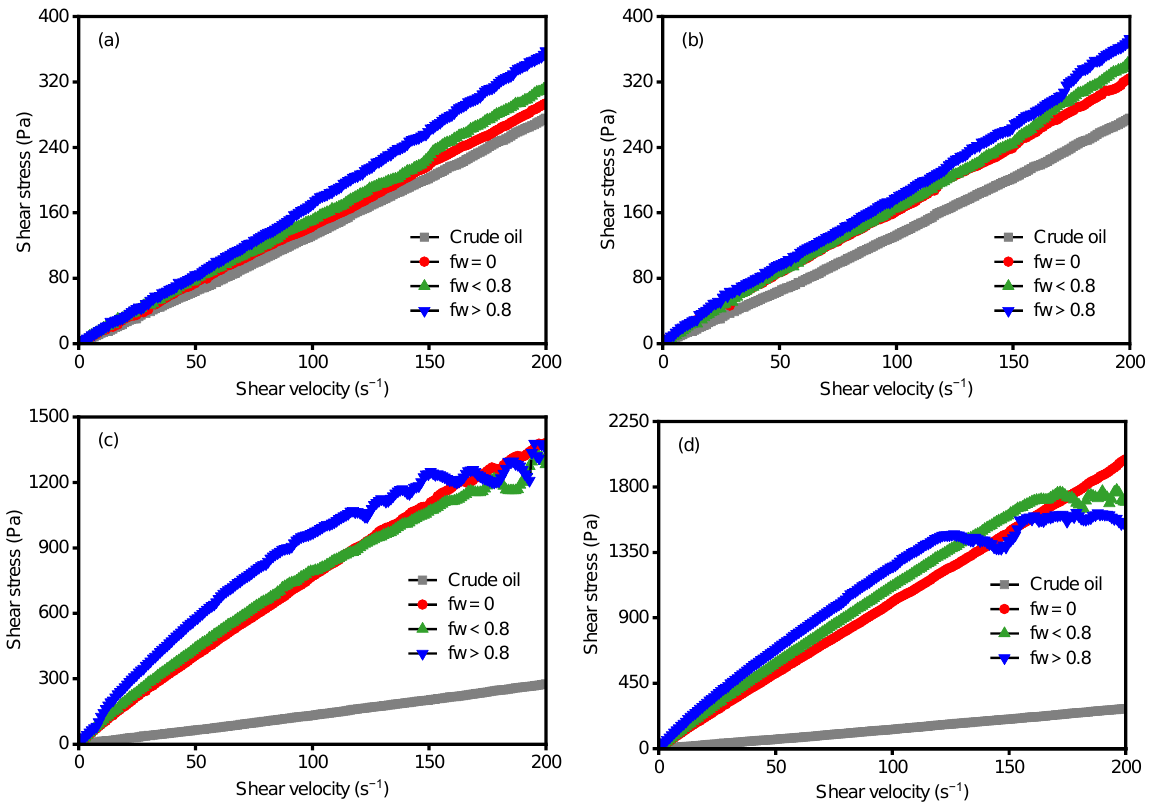
Figure 6. Rheology curves of shear stress as function of shear velocity for produced oils at different temperatures and velocities of injection steam. ( a ) 140 °C, 1 mL/min; ( b ) 140 °C, 5 mL/min; ( c ) 200 °C, 1 mL/min; ( d ) 200 °C, 5 mL/min.